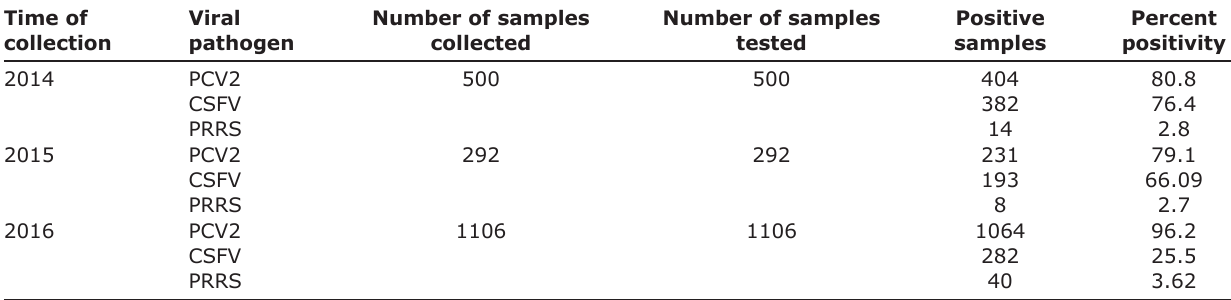
Table-2: Seroprevalence of PCV2, CSFV, and PRRS antibodies in serum samples of pig population in organized farms of Meghalaya as assessed by ELISA. Time of Viral collection